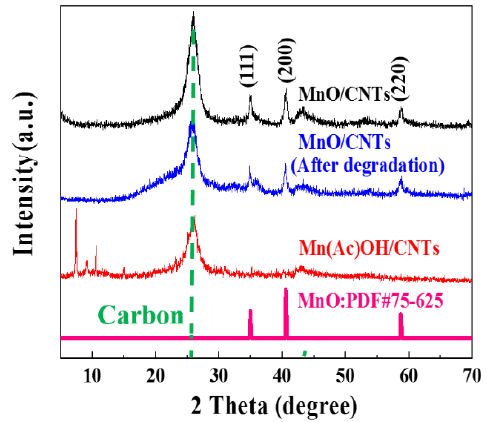
Figure 2. Structural characterization. X-ray diffraction patterns of Mn(Ac)OH/CNTs, MnO/CNTs, and MnO/CNTs after TC degradation under MI.